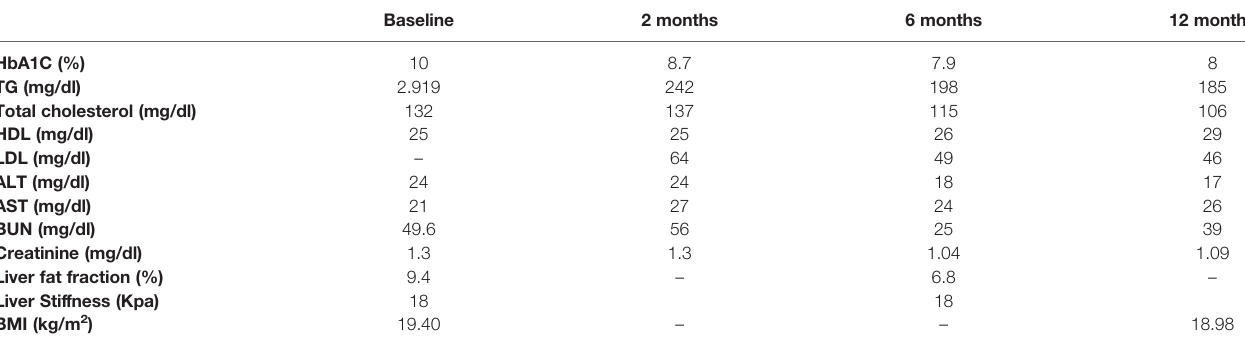
TABLE 2 | Summary of the results over 12 months of metreleptin